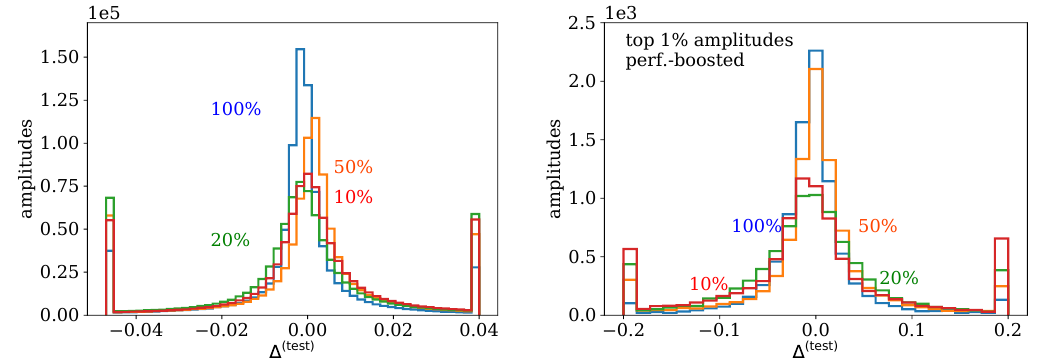
Figure 10: Performance of the BBN for all amplitudes (left) and a performance- boosted BNN for the largest 1% of all amplitudes (right), after training on different fractions of the full training